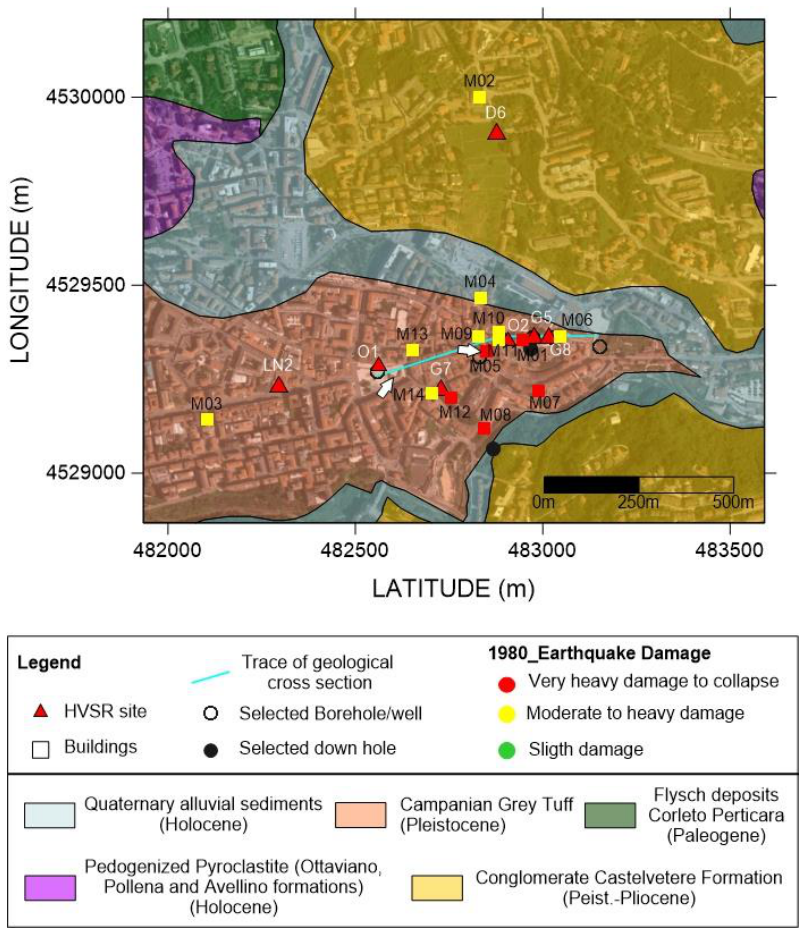
Figure 6. Geological map of the historical center of Avellino (modified from [5]). The white arrows indicate the position of the Piazza Libertà and the Torre dell’Orologio (Clock Tower, M05). Coordinates are in UTM (meters). Geosciences 2020 , 10 , x FOR PEER REVIEW